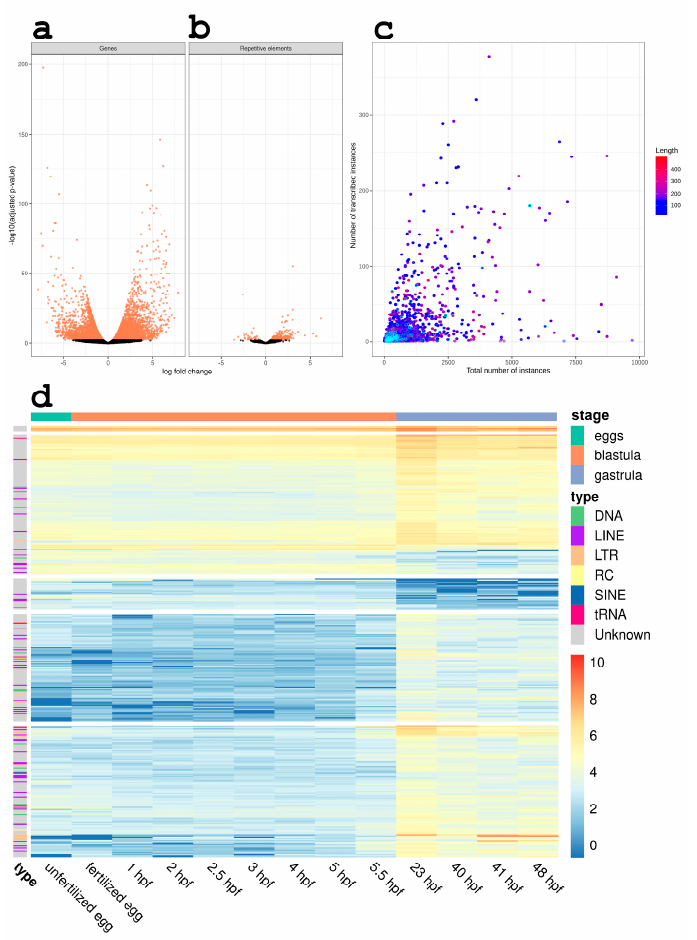
Figure 3. RE expression significantly changes during the gastrulation process irrespective of their origin and number of copies. Volcano plot showing differential expression of gene-coding transcripts ( a ) and RE ( b ) between blastula and gastrula stages. Each transcript is shown as a single point. Those with significantly changed levels are orange; black points are those without significant changes in transcription. ( c ) Scatter plot of expressed repetitive elements. X-axis represents the copy number of a given RE in the genome. Y-axis represents the number of transcribed copies of this element. Color gradient from blue to red indicates the length of the element. RE families with the length > 500 bp are shown with cyan dots. ( d ) Heat map of repetitive elements transcription that are differentially expressed during the gastrulation by embryo stages. Type column denotes the RE type. Class row denotes the embryo stage. Top 500 elements by their logFC were selected for this plot.